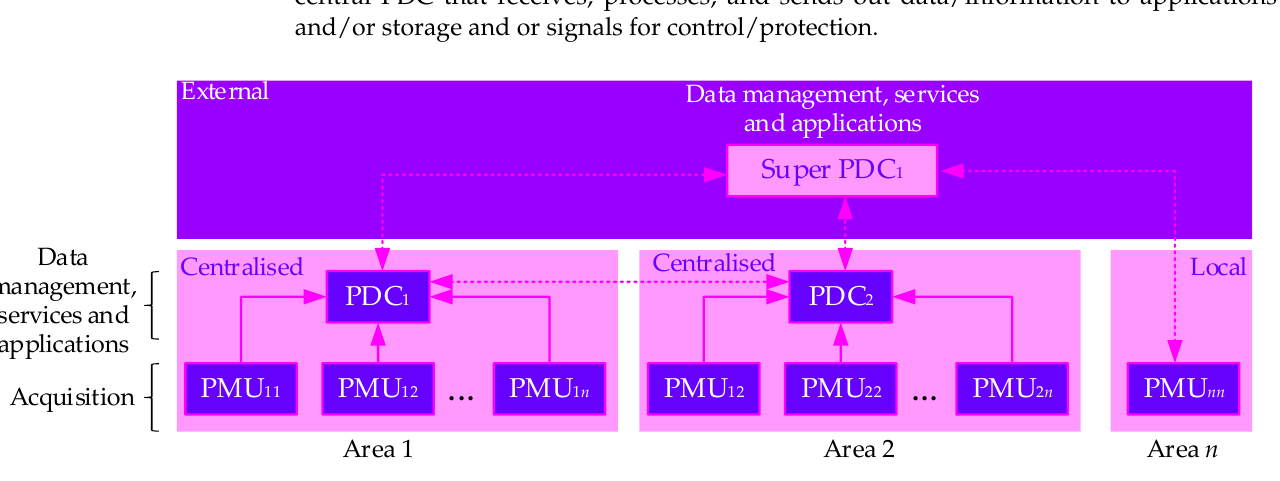
Figure 1. The generic architecture of phasor network architecture, suitable for WAMPAC.